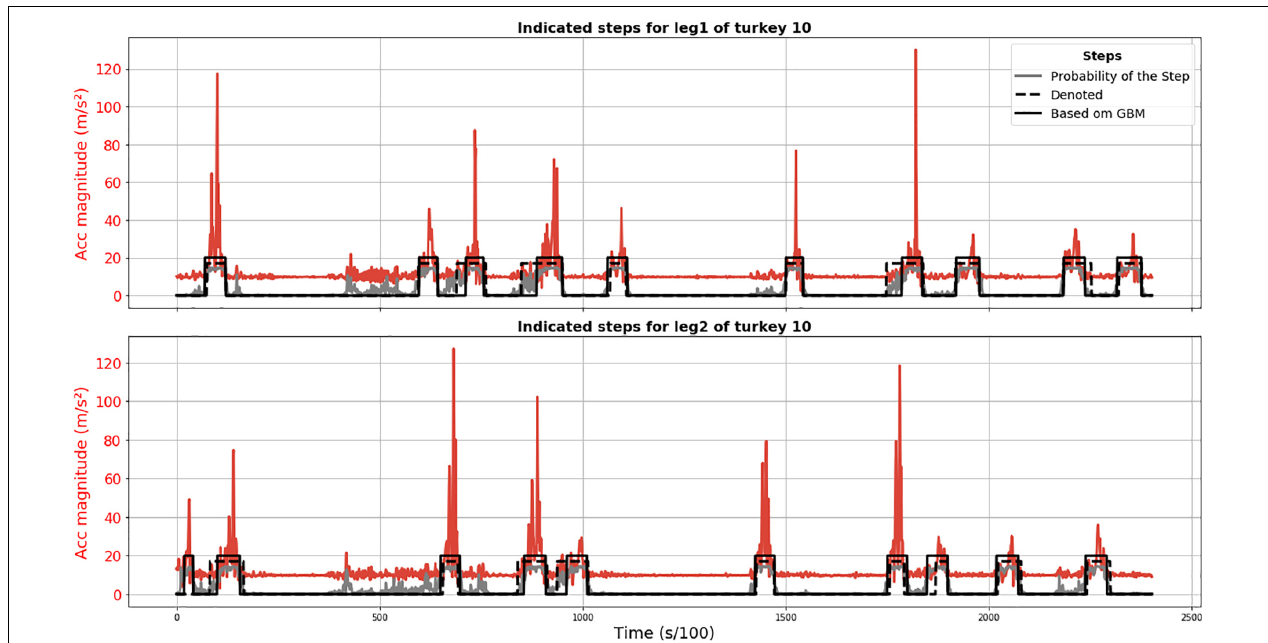
FIGURE 3 | Results of GBM step segmentation for turkey 010 (solid black line) for leg 1 (upper plot) and 2 (lower plot). Acceleration magnitude is plotted in red; dashed black line shows manually labeled steps. The gray line represents the chance of being a step according to the GBM model ( × 15 for visualization).